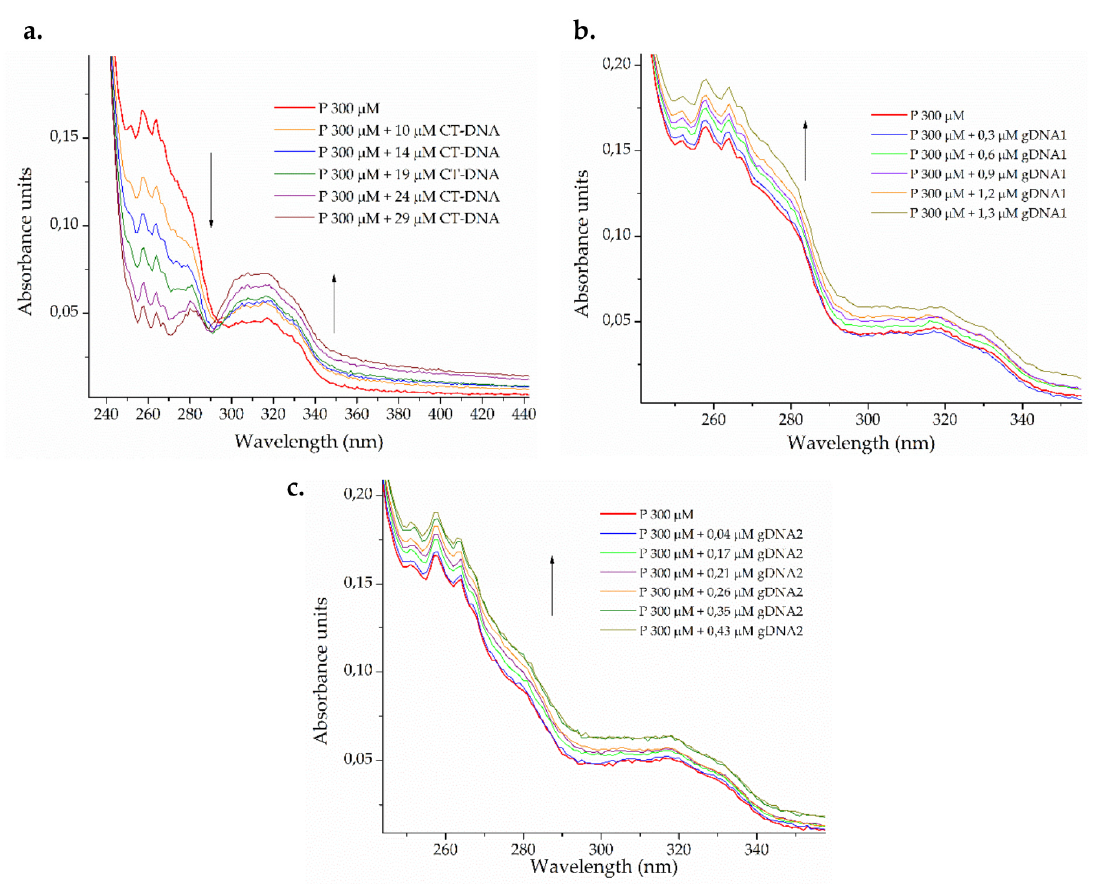
Figure 3. Photometric titration of 300 μ M Δ M2 peptide (P) with ( a ) eukaryotic calf thymus DNA (CT-DNA) and genomic DNA from ( b ) susceptible Pseudomonas aeruginosa ATCC 27853 (gDNA1) and ( c ) resistant Klebsiella pneumoniae ATCC 2146 (gDNA2).